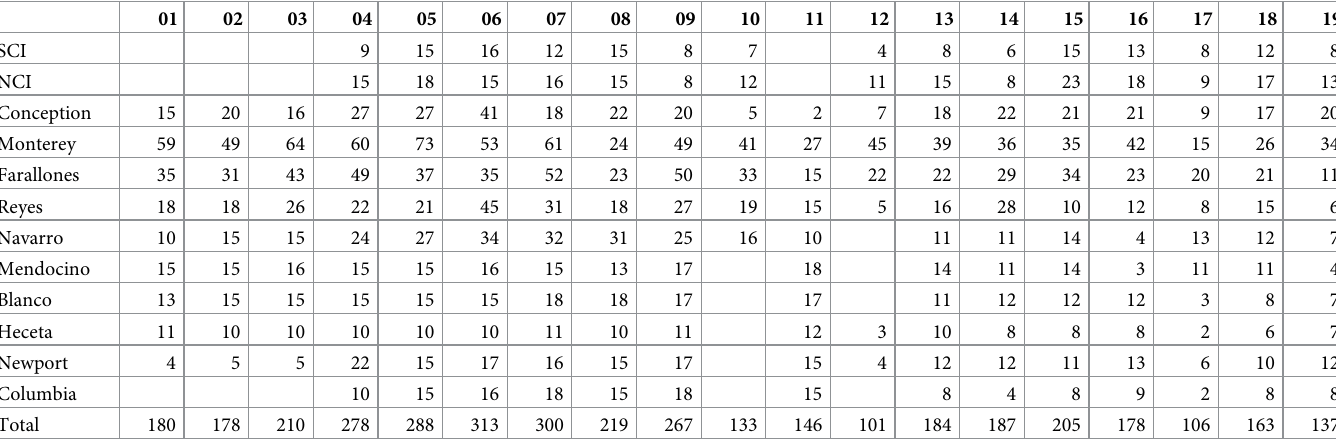
Table 1. Total number of successful hauls by region and year